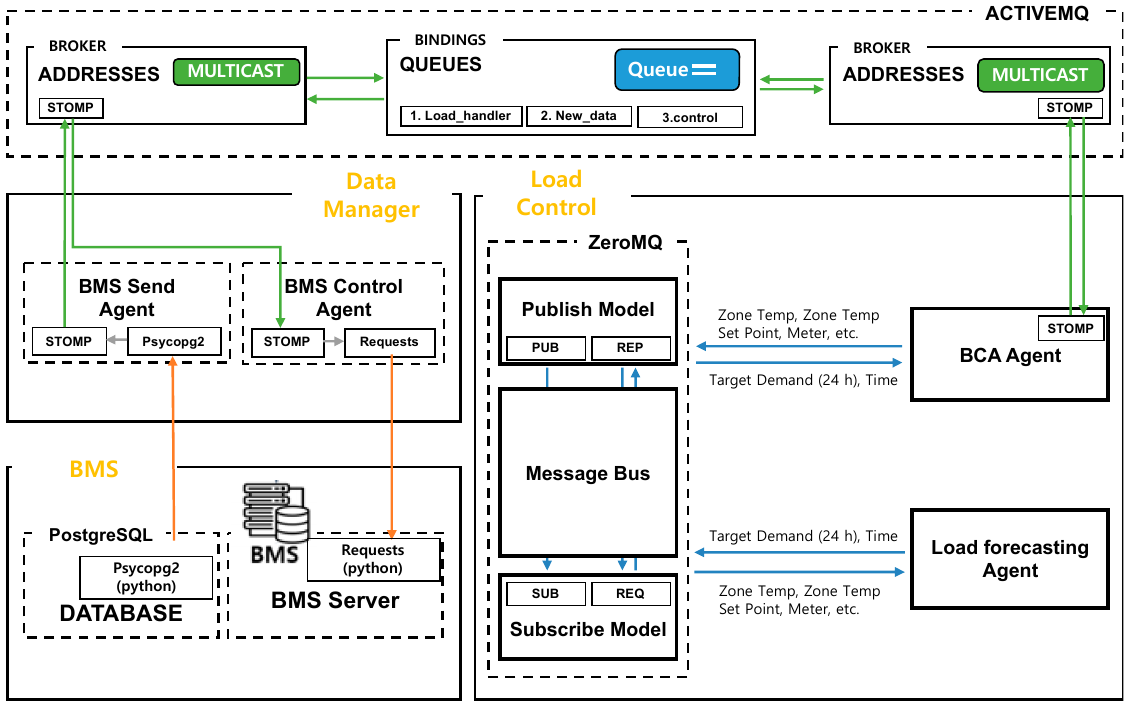
Figure 9. Field test implementation of the building control algorithm.